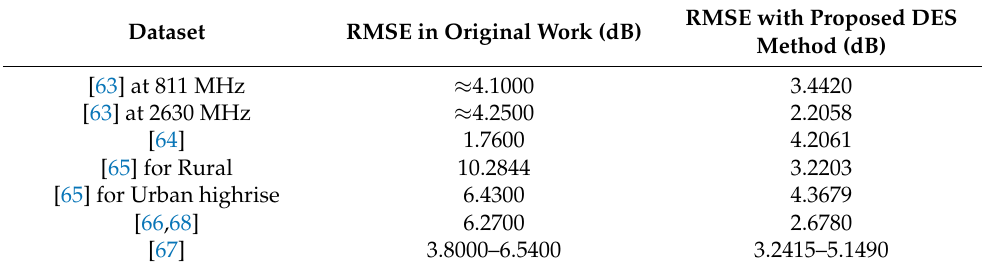
Table 7. Performance of proposed method on other